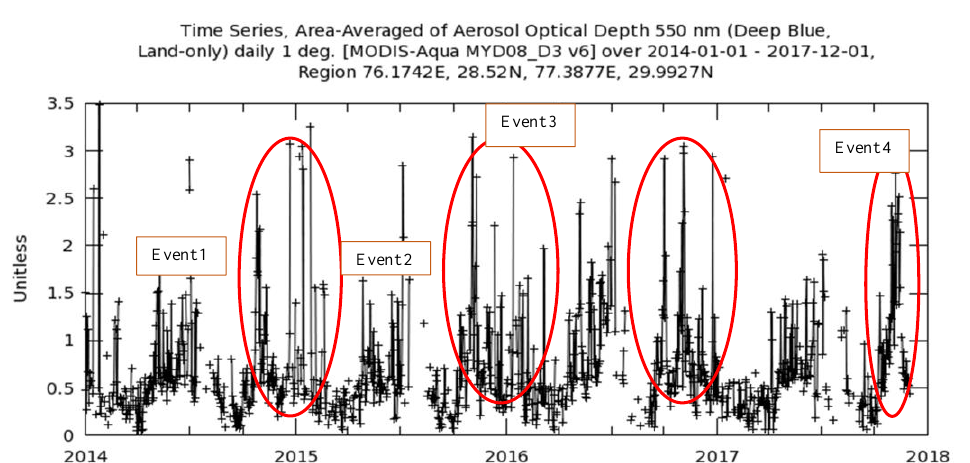
Figure 7: Aerosol Optical Depth of Delhi at 550nm